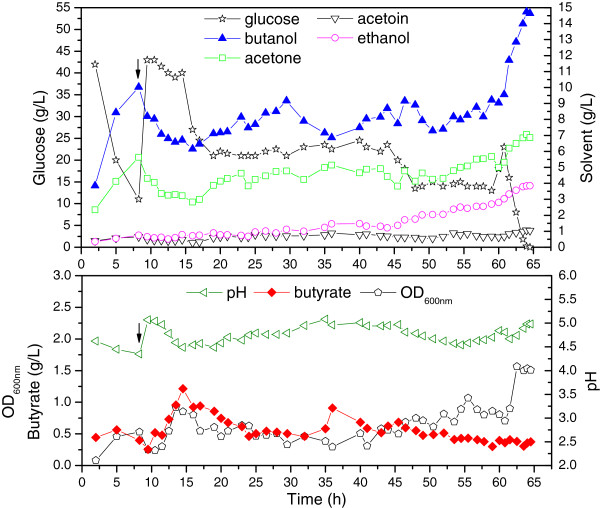
Kinetics of fed-batch fermentation in the biofilm reactor with co-adsorption of acetone. After 8 h of batch culture, concentrated medium was fed into the reactor to maintain desired glucose levels and the fixed-bed adsorption was started, as is indicated by arrows. By co-adsorption of acetone using KA-I resin, the acetone titer in the fermentation broth was also maintained at a relatively stable level. OD, optical density.